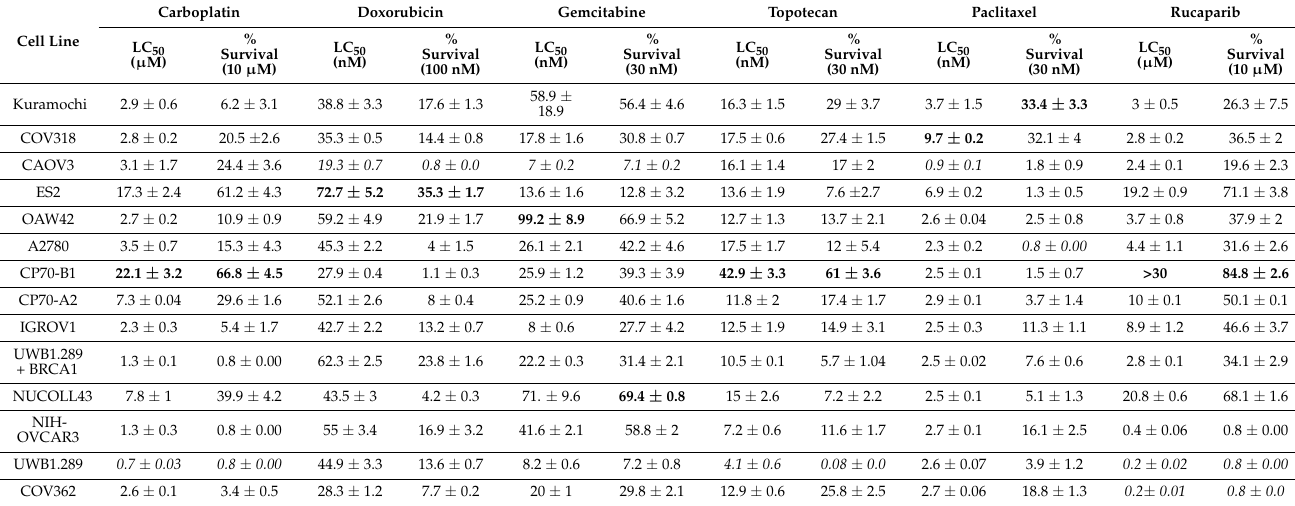
Table 1. LC 50 values (mean ± SD) and % survival at a given concentration (mean ± SD) of carboplatin, doxorubicin, gemcitabine, topotecan, paclitaxel, and rucaparib for the 14 cell line panel is listed below. Each data represents an average of three independent experiments. (Bold: Highest value; Italics: Lowest